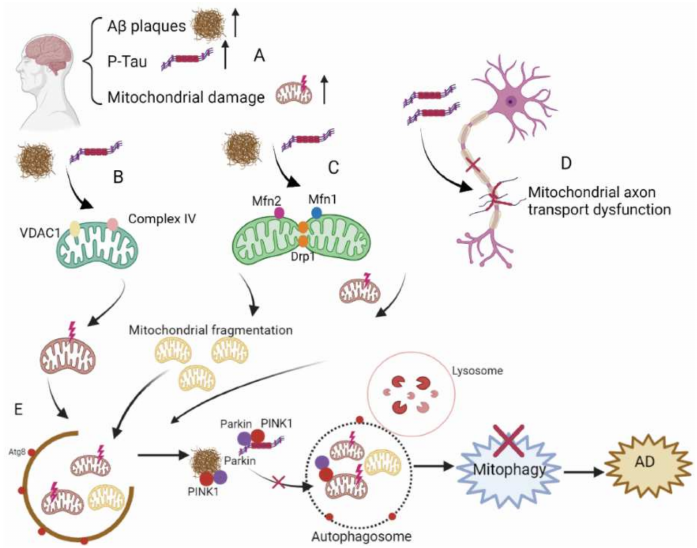
Figure 2. Mitophagy in the pathogenesis of AD. ( A ) Impairment of the mitochondria occurs in the early stages of AD, and A β and P-tau are increased. ( B ) A β and P-tau interact with VDAC1 and Complex IV, and interfere with mitochondrial function. ( C ) A β and P-tau induce mitochondrial fragmentation by reducing MFN1/2 and activating Drp1. ( D ) Hyperphosphorylation of tau blocks the binding of tau with microtubules, disrupting mitochondrial axon transport. ( E ) A β and P-tau disturb the recruitment of PINK1 and Parkin, causing mitophagy